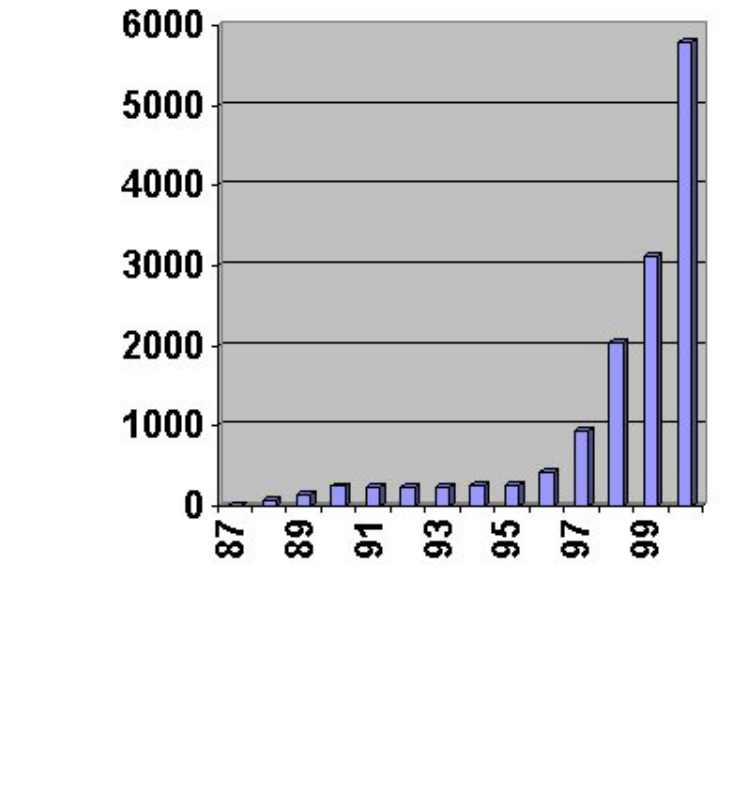
Figure 1: Number of course enrolments in online courses from